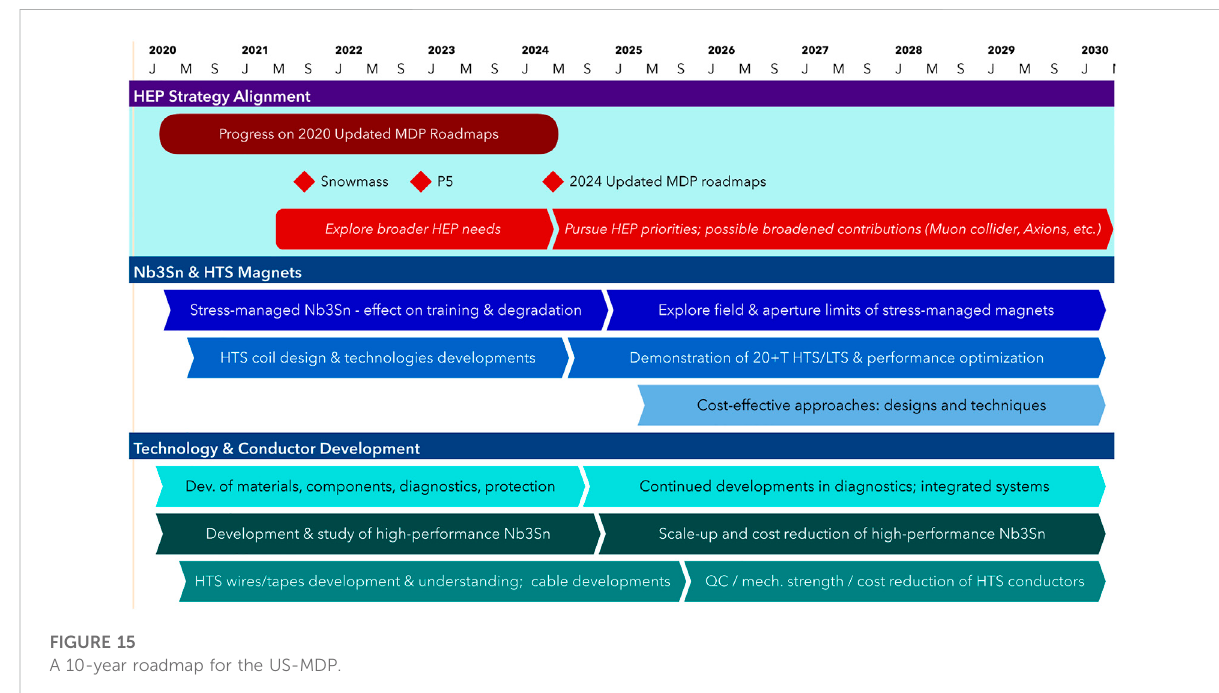
FIGURE 15 A 10-year roadmap for the